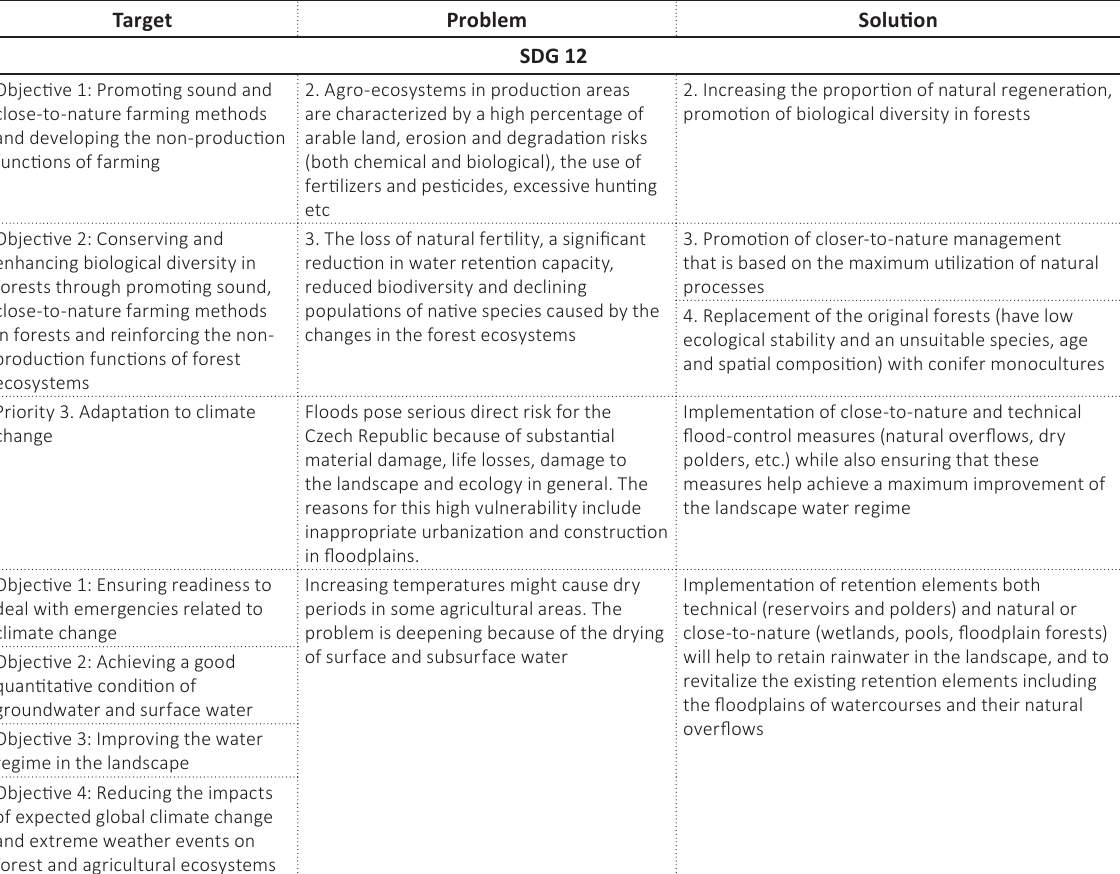
Table 6 (cont.). Problems arising in the process of achieving SDGs 12 in the Czech Republic, and solutions to come up with